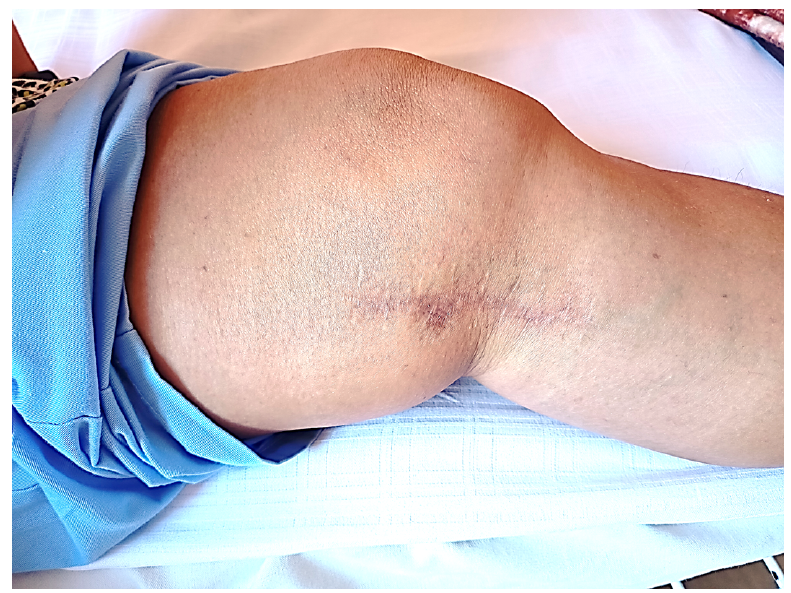
Figure 5. The local state of the wound 2 months after completing the topical ozone therapy proce- dures.